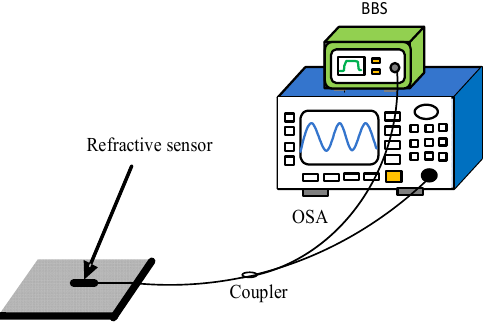
Figure 7. Refractive index sensing experimental device schematic diagram.